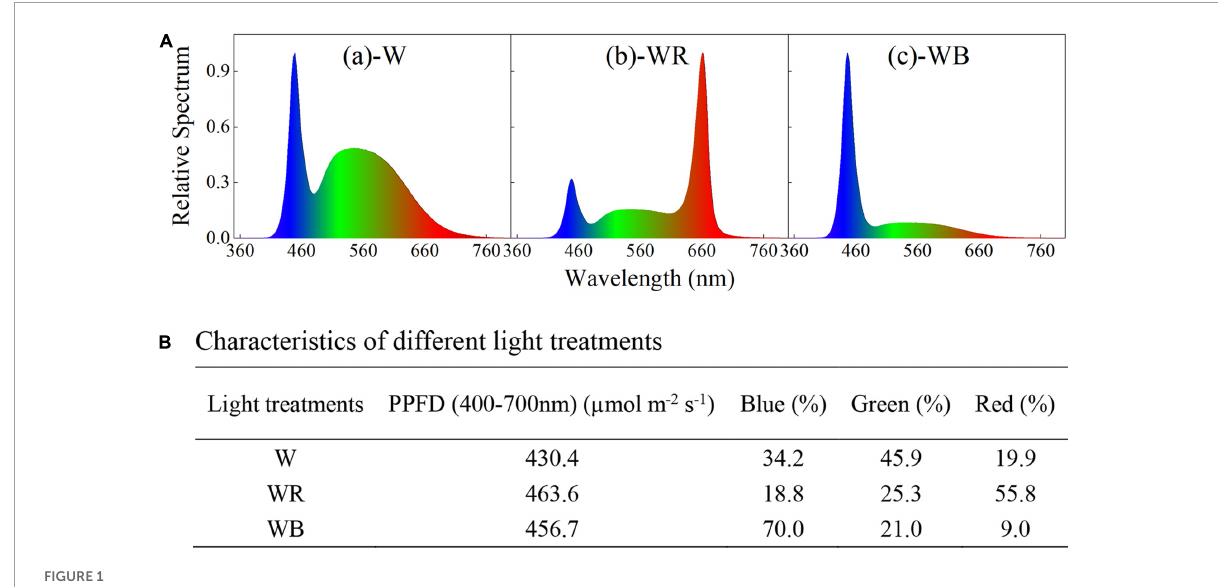
FIGURE1 Spectral distribution (A) and characteristics (B) of different light treatments. (A-a) White light emitting diodes (LEDs) (W); (A-b) white plus red LEDs (WR); (A-c) , white plus blue LEDs (WB). Photosynthetic photon flux density (PPFD) for each light treatment was equal to 450 ± 20 µ mol m 2 s − 1